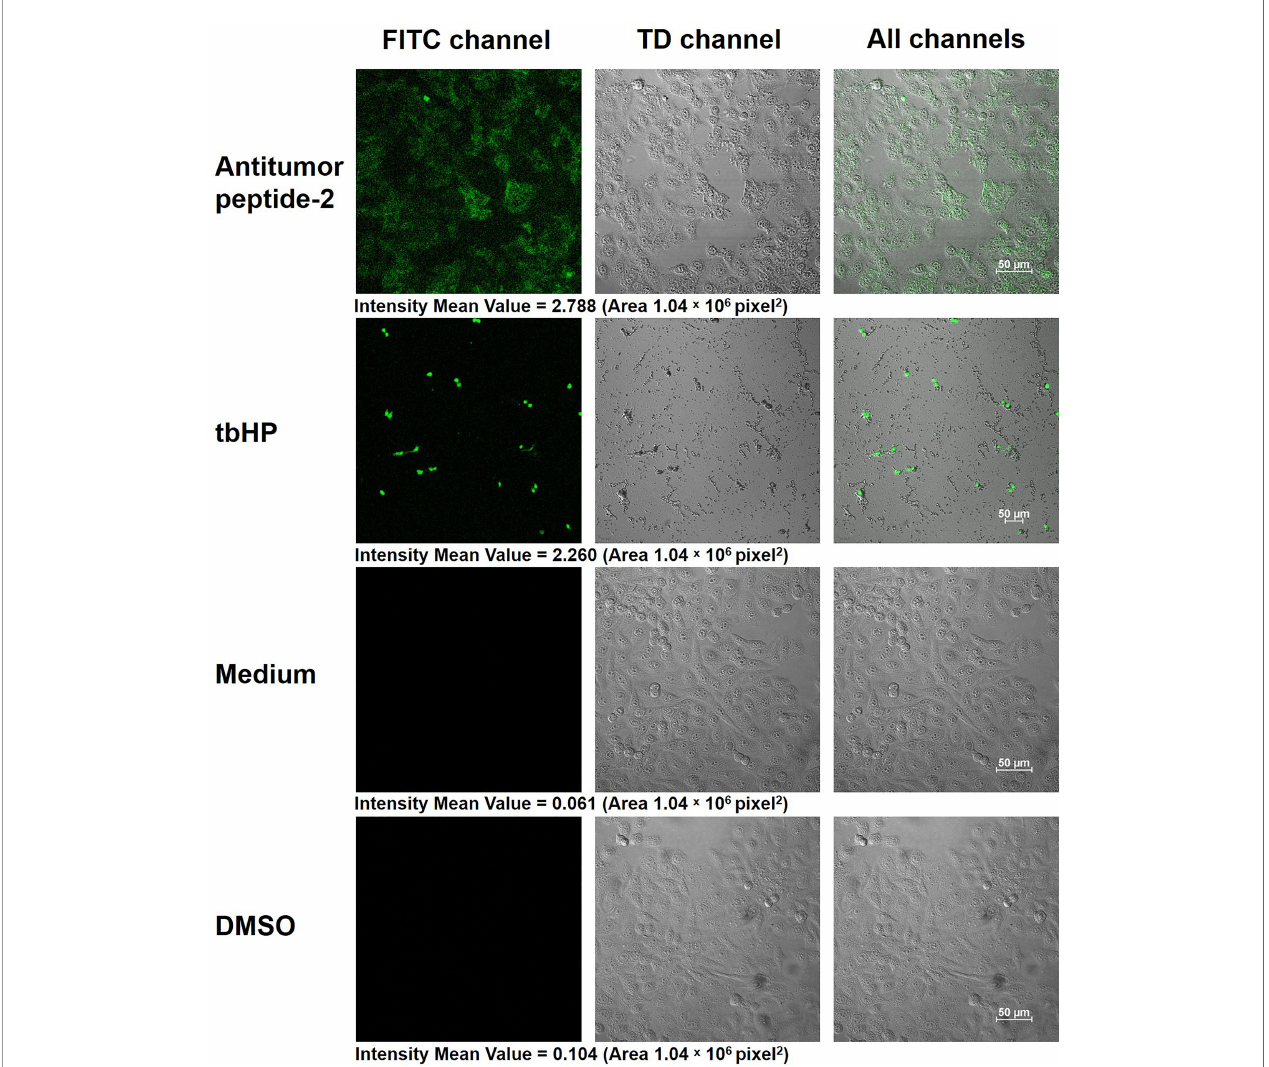
FIGURE 8 | Production of reactive oxygen species (ROS) within HepG2 cells after antitumor peptide 2 treatment. HepG2 cells (1 × 10 5 cells) were treated with 337 µgmL -1 of antitumor peptide 2, 50 µM of tert-butyl hydrogen peroxide (tbHP; positive control), medium alone (negative control), and 1% DMSO (diluent control) for 24 h. All cells were stained with 2 ’ , 7 ’ -dichloro fl uorescin diacetate (DCFDA) solution (DCFDA/H2DCFDA-Cellular ROS Assay Kit) and visualized by confocal microscopy at 400× magni fi cation. Images were recorded under FITC, TD, and all channels. Scale bar = 50 m